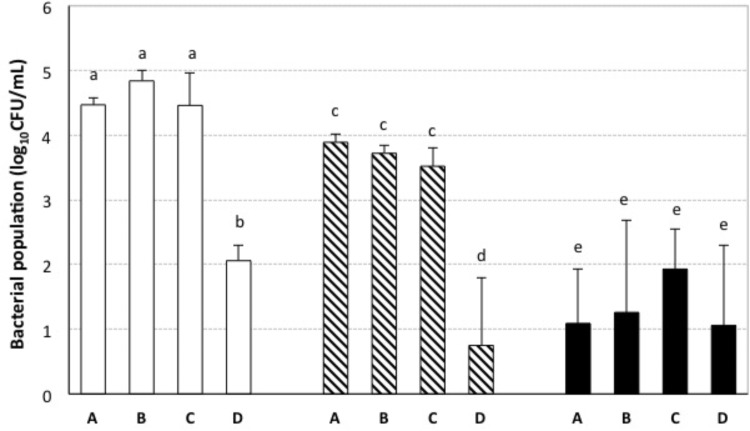
LAB populations in wines submitted to aging with addition of different combinations of nisin and potassium metabisulphite. Bacterial populations (log10CFU/mL) were measured after 3 months of aging. Potassium metabisulphite concentrations: 18 mg/L; 25 mg/L; 100 mg/L nisin concentrations: A = 0 mg/L, B = 0.78 mg/L, C = 6.25 mg/L, and D = 50 mg/L. Different letters (a, b, c, d, e) indicate significant differences (p < 0.05; variable parameter: nisin concentration) among data obtained for the wines treated with the same concentration of potassium metabisulphite.